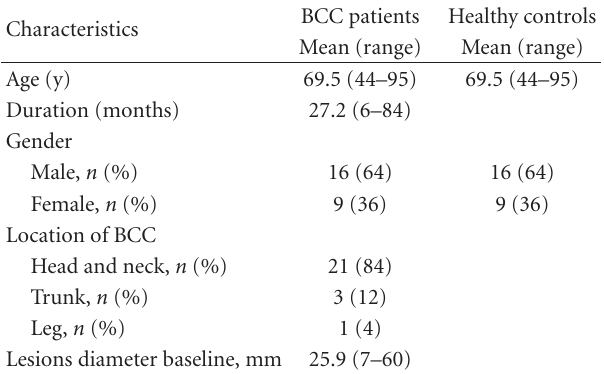
Table 1: Sociodemographic and medical characteristics of 25 Caucasian BCC patients and 25 healthy controls matched by gender and age. Duration between first notice and treatment time and diameter of lesions at baseline are stated.